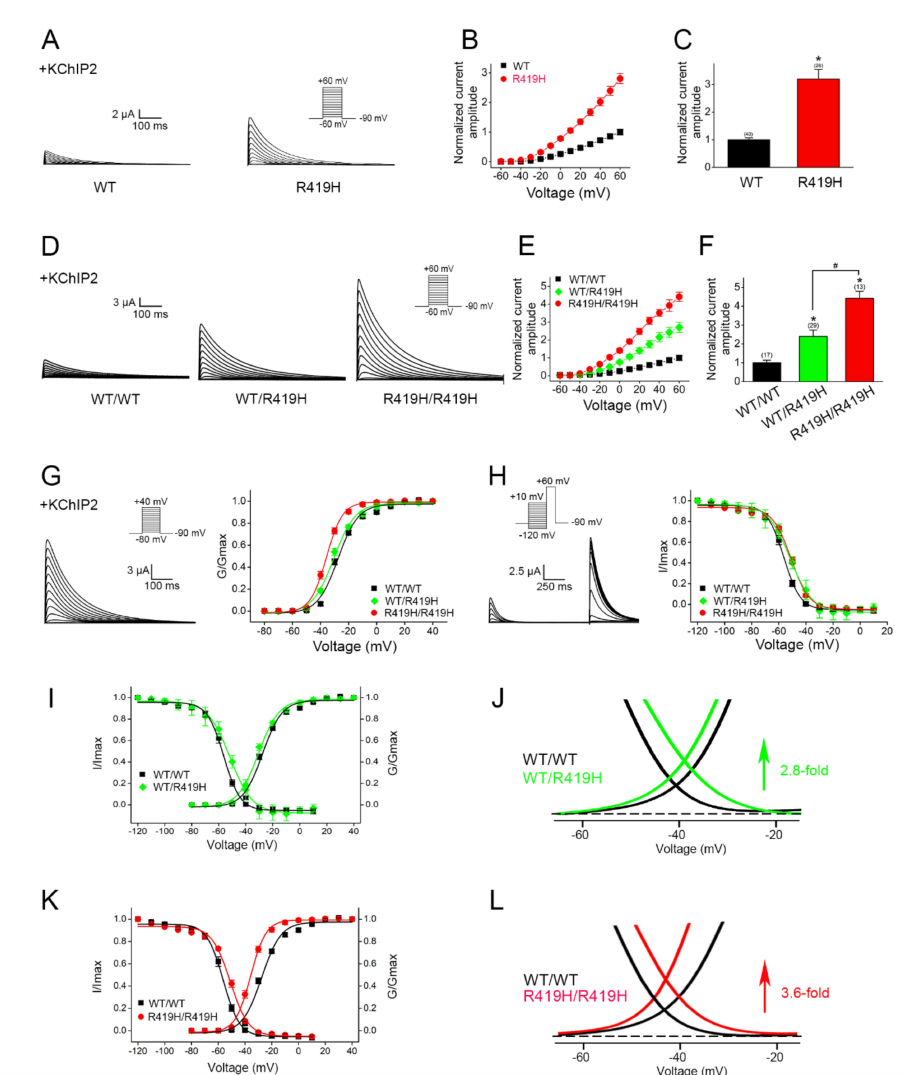
Figure 4. Characterization of the ion channel function of human K V 4.3 WT and the p.R419H variant. K V 4.3 was co-expressed with the auxiliary KChIP2 subunit in the 1:1 molar ratio in Xenopus oocytes. ( A – C ) Compared to K V 4.3 WT, the p.R419H variant is associated with a significantly higher functional expression level. ( A ) Representative K + current traces recorded from homotetrameric K V 4.3 WT and p.R419H channels. Current traces were induced by a voltage protocol comprising test potentials ranging from –60 mV to +60 mV in 10-mV steps. ( B ) Normalized peak current amplitudes were plotted against matching test pulse potentials. For each current trace induced by a test pulse potential, the peak current amplitude was measured, followed by normalization with respect to the corresponding mean peak current amplitude at +60 mV of K V 4.3 WT. ( C ) Statistical comparison of the normalized peak current amplitude at +60 mV. Mean normalized peak current amplitude at +60 mV: WT, 1 ± 0.1; p.R419H, 3.2 ± 0.3. Asterisks denote significant difference from the WT control ( p < 0.05). Numbers in parentheses refer to the amount of cells analyzed for each K V 4.3 construct. ( D – F ) The p.R419H variant exerts a dominant effect on the functional expression of K V 4.3 channels. ( D ) Representative current traces recorded from K V 4.3 WT/WT homotetramers, WT/R419H heterotetramers, and R419H/R419H homotetramers. ( E )